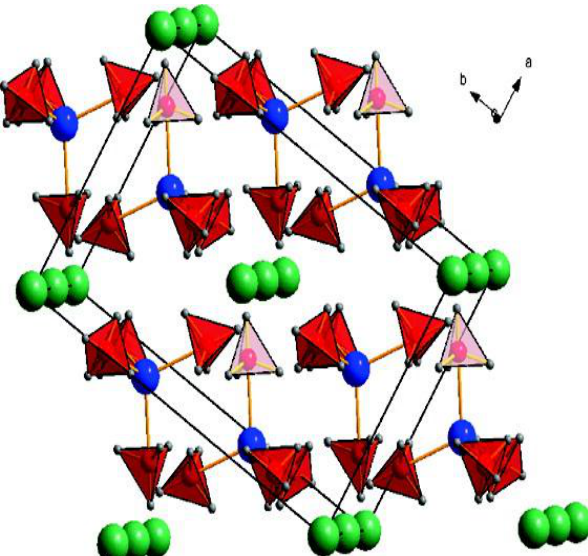
Figure 9. Crystal structure of NaSc(BH 4 ) 4 showing the coordination of Sc atoms (blue) by BH 4 tetrahedra (red); Na atoms are in green [76]. Reprinted with permission from [76], copyright 2010 The American Chemical